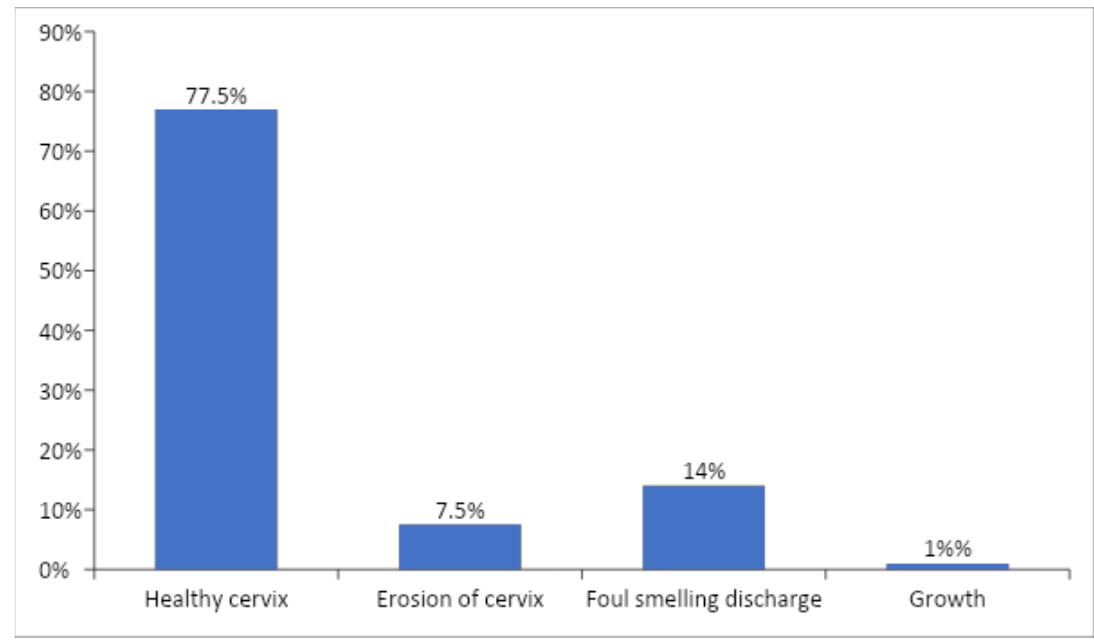
Fig. 1: Distribution of study participants based on the per speculum examination (N=200)